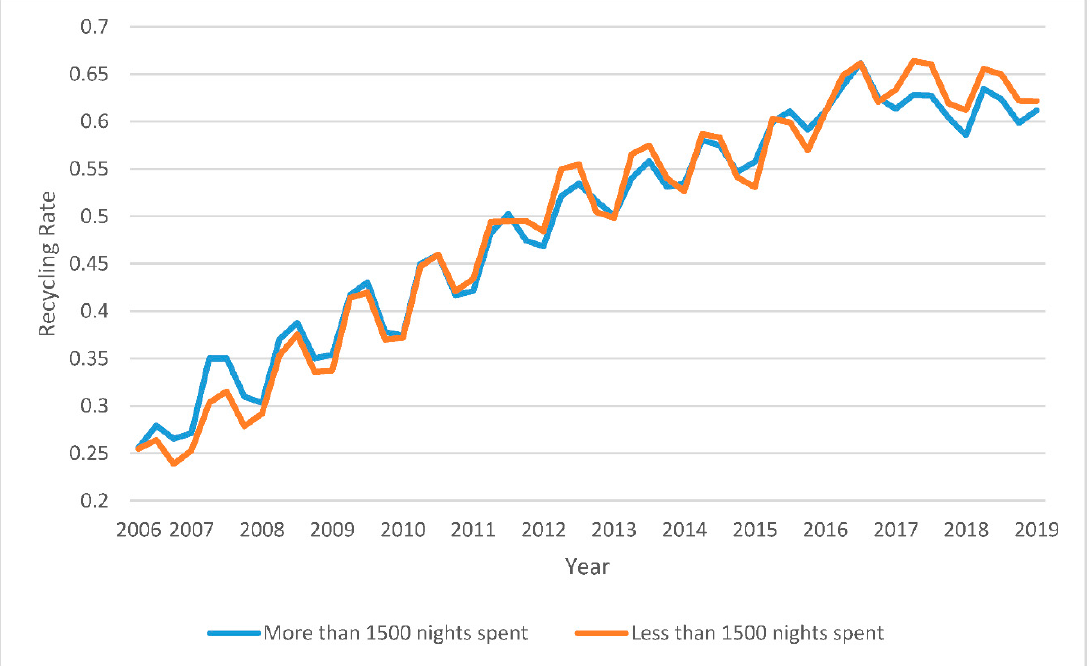
Figure A5. Average recycling rate for local authorities with more/less than 1500 nights spent in by international travellers per year. Source: WasteDataFlow and the Tourism Profile.